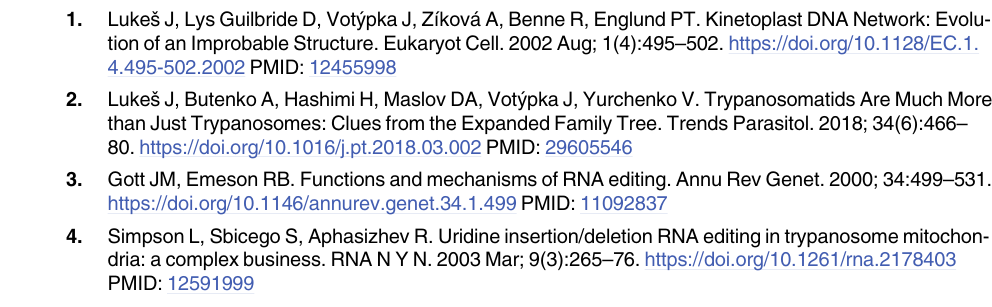
S1 Table. Short repeat conserved region. S2 Table. T . cruzi strains